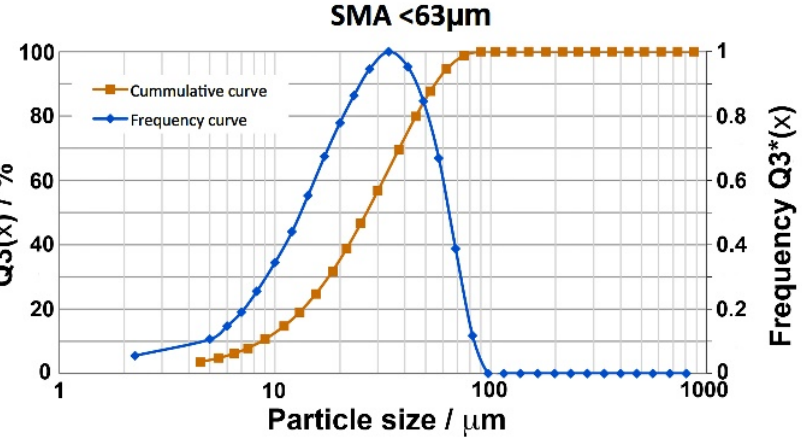
Figure 1. Particle size distribution: frequency and cumulative integral curves for the atomization process of the Cu–Al–Ni SMAs.